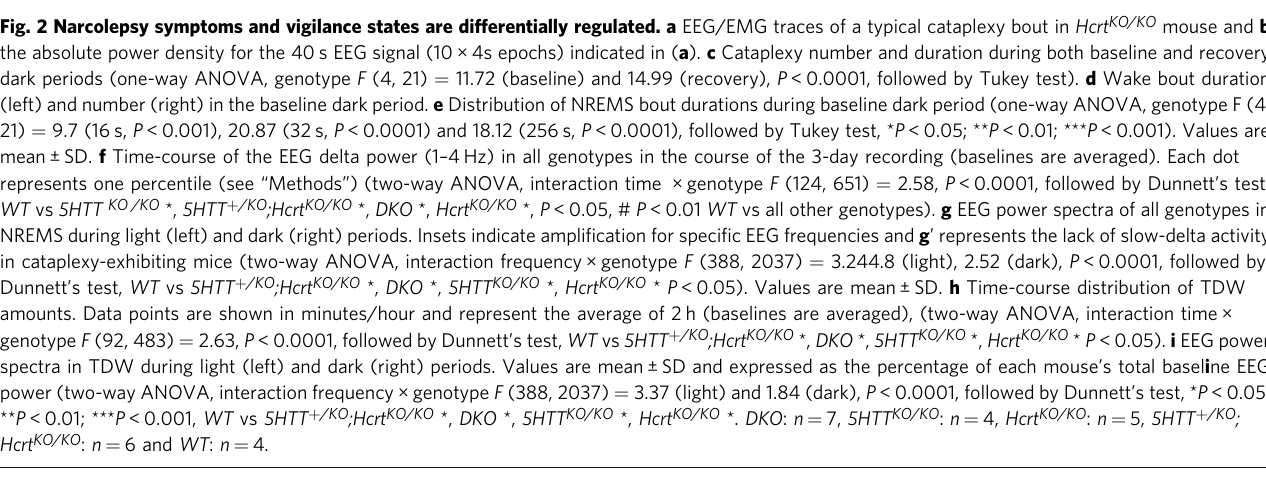
Fig. 2 Narcolepsy symptoms and vigilance states are differentially regulated. a EEG/EMG traces of a typical cataplexy bout in Hcrt KO/KO mouse and b the absolute power density for the 40 s EEG signal (10 × 4s epochs) indicated in ( a ). c Cataplexy number and duration during both baseline and recovery dark periods (one-way ANOVA, genotype F (4, 21) = 11.72 (baseline) and 14.99 (recovery), P < 0.0001, followed by Tukey test). d Wake bout duration (left) and number (right) in the baseline dark period. e Distribution of NREMS bout durations during baseline dark period (one-way ANOVA, genotype F (4, 21) = 9.7 (16 s, P < 0.001), 20.87 (32 s, P < 0.0001) and 18.12 (256 s, P < 0.0001), followed by Tukey test, * P < 0.05; ** P < 0.01; *** P < 0.001). Values are mean ± SD. f Time-course of the EEG delta power (1 – 4 Hz) in all genotypes in the course of the 3-day recording (baselines are averaged). Each dot represents one percentile (see “ Methods ” ) (two-way ANOVA, interaction time × genotype F (124, 651) = 2.58, P < 0.0001, followed by Dunnett ’ s test, WT vs 5HTT KO/KO *, 5HTT + /KO ;Hcrt KO/KO *, DKO *, Hcrt KO/KO *, P < 0.05, # P < 0.01 WT vs all other genotypes). g EEG power spectra of all genotypes in NREMS during light (left) and dark (right) periods. Insets indicate ampli fi cation for speci fi c EEG frequencies and g ’ represents the lack of slow-delta activity in cataplexy-exhibiting mice (two-way ANOVA, interaction frequency× genotype F (388, 2037) = 3.244.8 (light), 2.52 (dark), P < 0.0001, followed by Dunnett ’ s test, WT vs 5HTT + /KO ;Hcrt KO/KO *, DKO *, 5HTT KO/KO *, Hcrt KO/KO * P < 0.05). Values are mean ± SD. h Time-course distribution of TDW amounts. Data points are shown in minutes/hour and represent the average of 2 h (baselines are averaged), (two-way ANOVA, interaction time × genotype F (92, 483) = 2.63, P < 0.0001, followed by Dunnett ’ s test, WT vs 5HTT + /KO ;Hcrt KO/KO *, DKO *, 5HTT KO/KO *, Hcrt KO/KO * P < 0.05). i EEG power spectra in TDW during light (left) and dark (right) periods. Values are mean ± SD and expressed as the percentage of each mouse ’ s total basel i ne EEG power (two-way ANOVA, interaction frequency × genotype F (388, 2037) = 3.37 (light) and 1.84 (dark), P < 0.0001, followed by Dunnett ’ s test, * P <